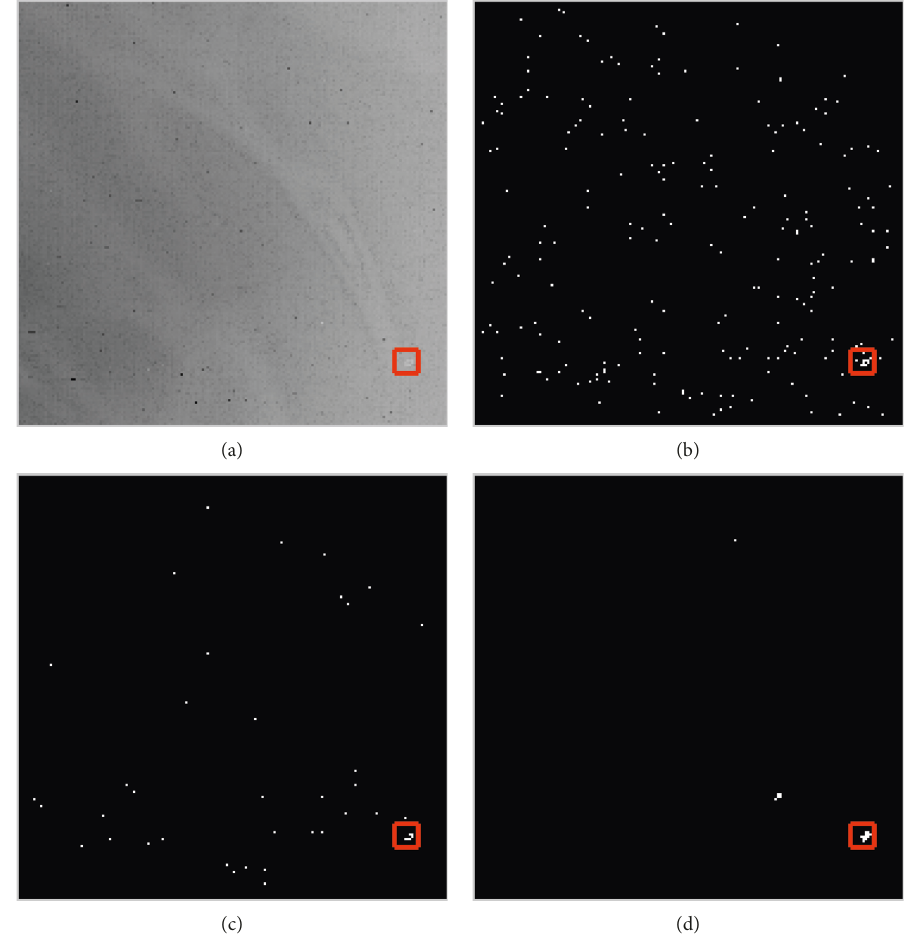
Figure 3: Segmentation results of different algorithms in scene 1.